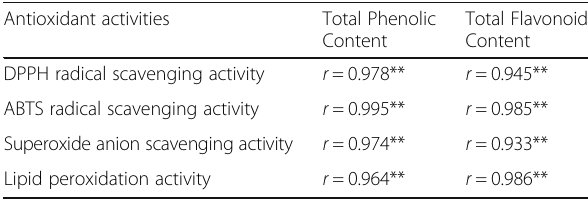
Table 5 Pearson ’ s correlation coefficients between TPC, TFC and antioxidant activities of TES17 extract